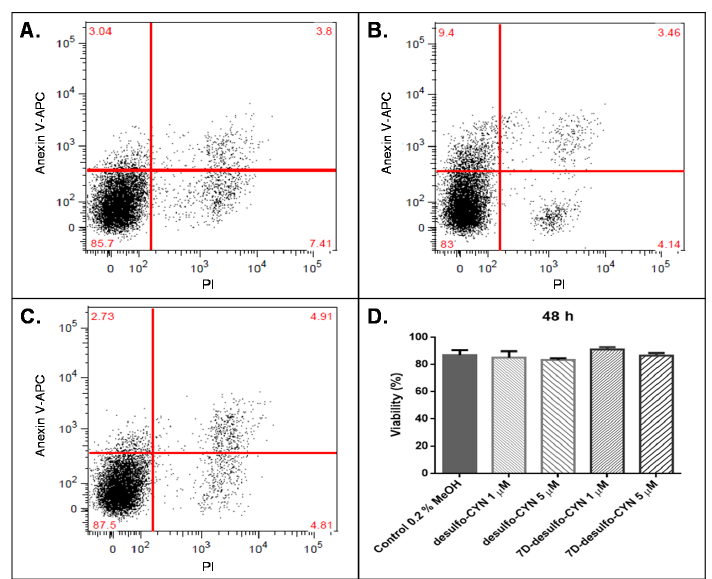
Figure 7. Biological activity of desulfo-CYN and 7D-desulfo-CYN purified from C. raciborskii 11K on HepG2 cells analyzed by flow cytometry using propidium iodide (PI) as the necrosis marker and annexin V-APC as the apoptosis marker. ( A ) Example of a 48-h negative control 0.2% MeOH. ( B ) Example of a 48-h treatment with 5 µM desulfo-CYN. ( C ) Example of a 48-h treatment with 5 µM 7D-desulfo-CYN. ( D ) Viability after a 48-h treatment using 1 and 5 µM of desulfo-CYN and 7D-desulfo-CYN (n = 4). APC: allophycocyanin signal; statistical comparisons between groups (control vs. treatment) were performed using Mann-Whitney U tests; p <